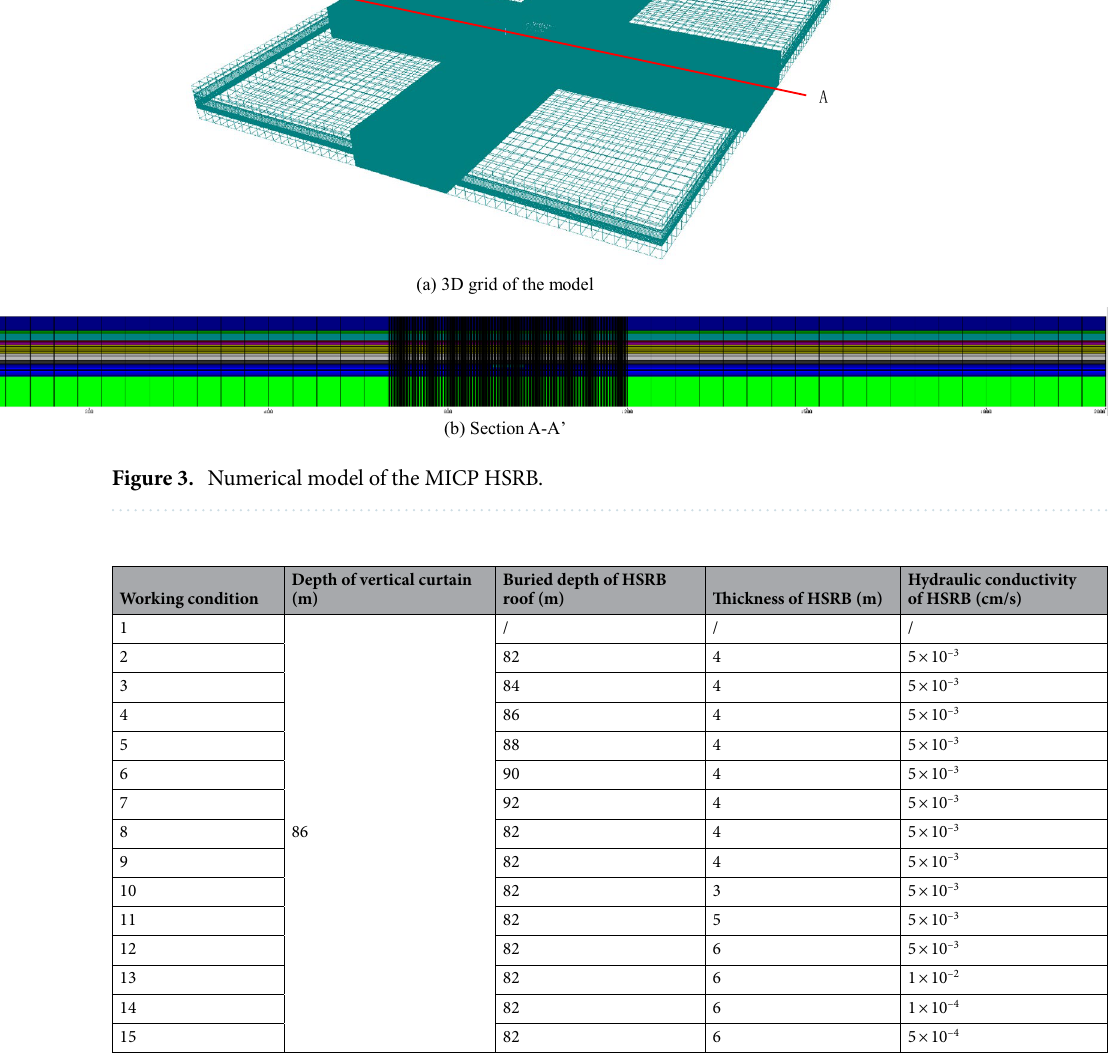
Table 3. Working conditions of the influence of 3D curtain on deep foundation pit dewatering.